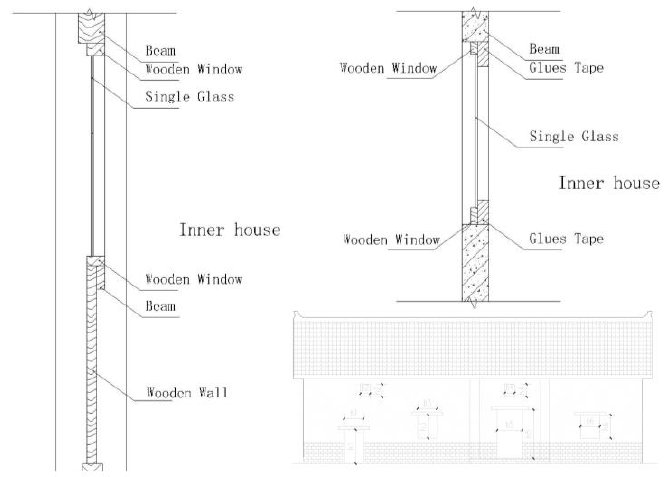
Figure 12. External window renewal method. Table 10. Heat transfer coefficients of external windows.